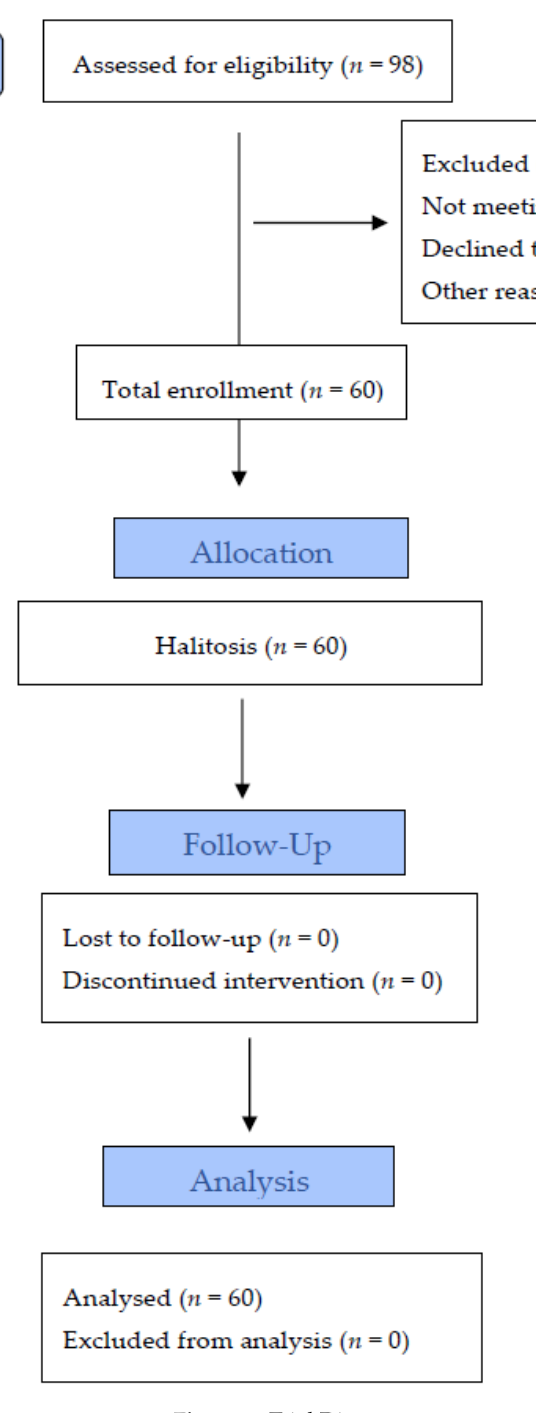
Figure 1. Trial Diagram.